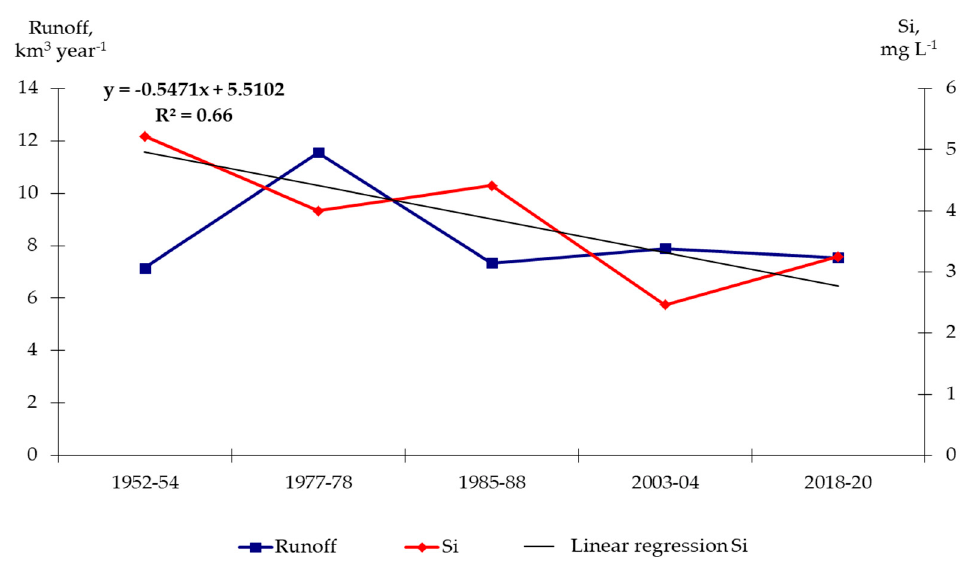
Figure 13. Long-term trend in silicates’ concentration and its relationship with runoff value [13,67,68].